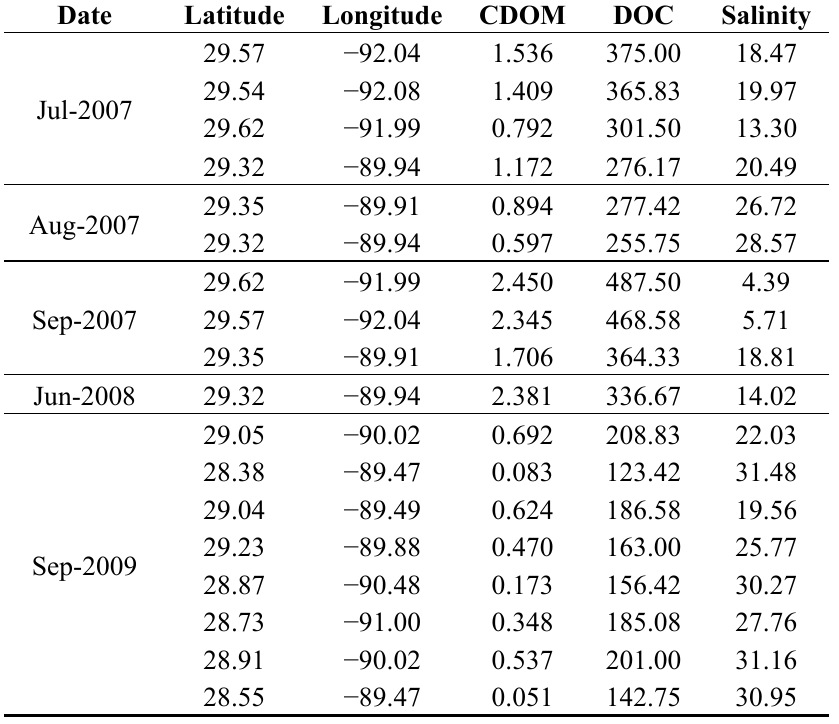
(412), DOC, and salinity data used in Figure CDOM